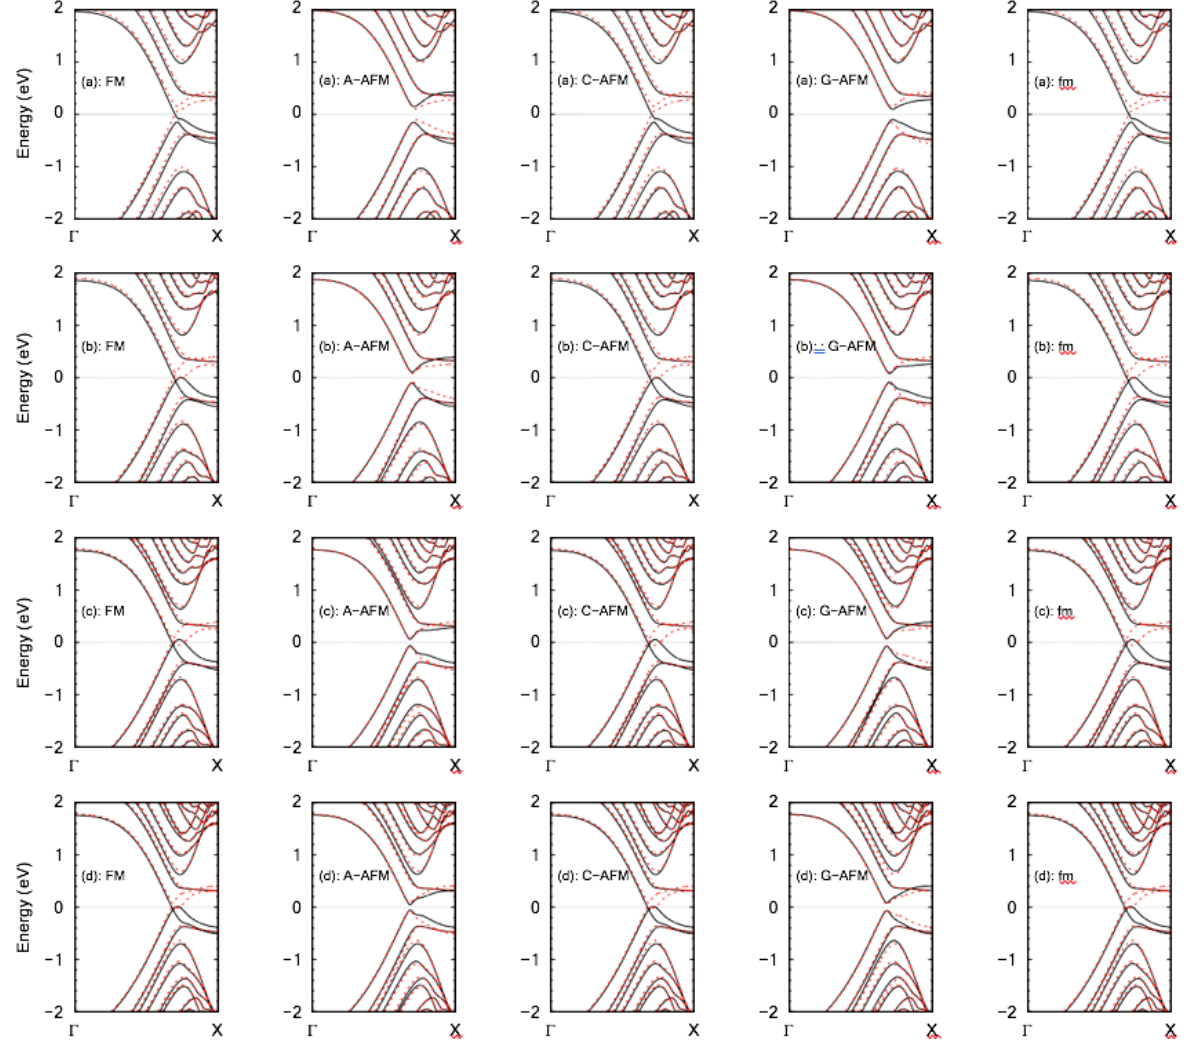
Fig. 3. Energy dispersion relations of bilayer 6-ZGNR (a), 8-ZGNR (b), 12-ZGNR (c), 14-ZGNR (d) at thickness d = 3 . 35 A˚ . The Fermi energy E F = 0 is shown by the horizontal dashed line. Meanwhile, the states of spin up and spin down are represented by the solid and dashed lines,